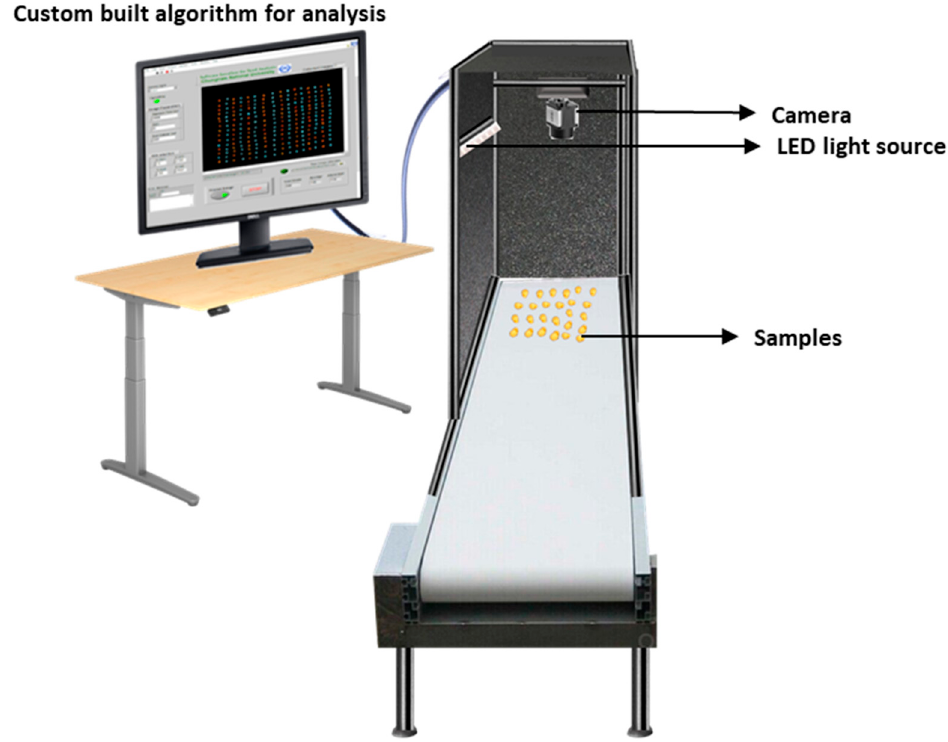
Figure 2. Schematic diagram of image acquisition for samples.